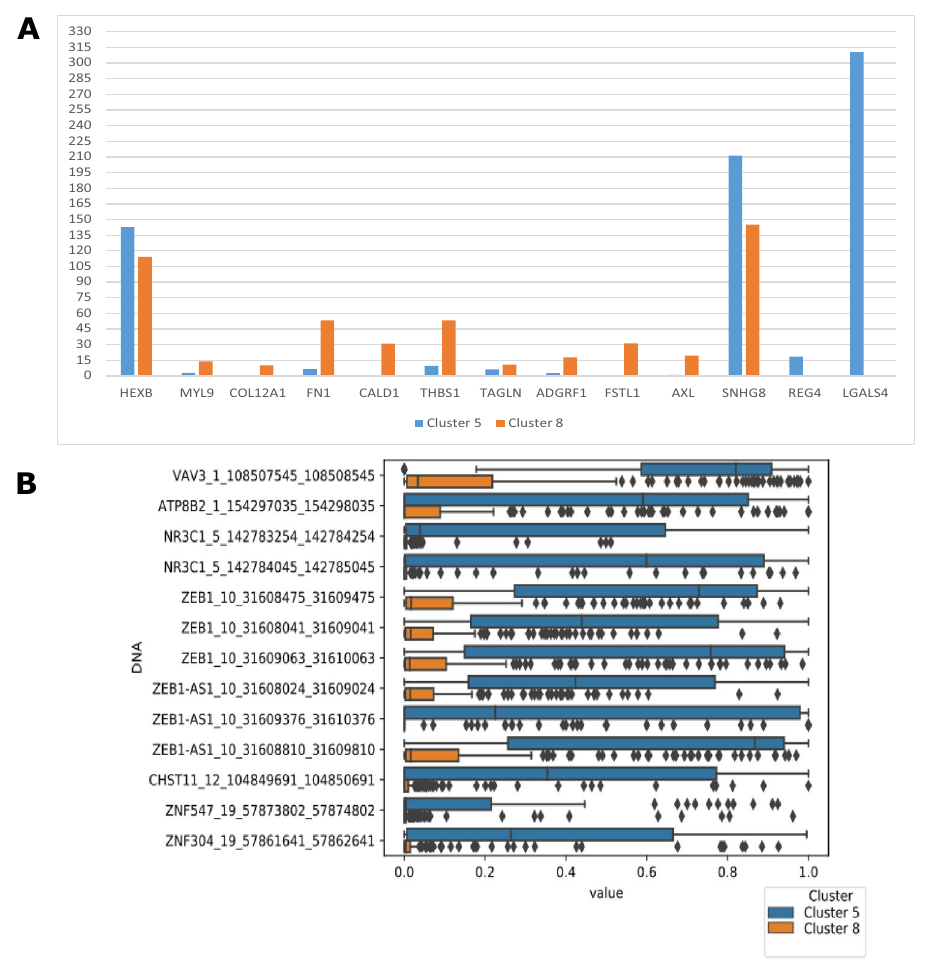
Figure 4. ( A ) Median Log2(TPM + 1) values of genes in cluster 5 and cluster 8. This shows the main drivers behind the stratification of cluster 5 and cluster 8. ( B ) DNA promoter region of cluster 5 and cluster 8. Although cluster 5 and cluster 8 both contain the same cancer tissues, a different methylation pattern is observed for certain regions.